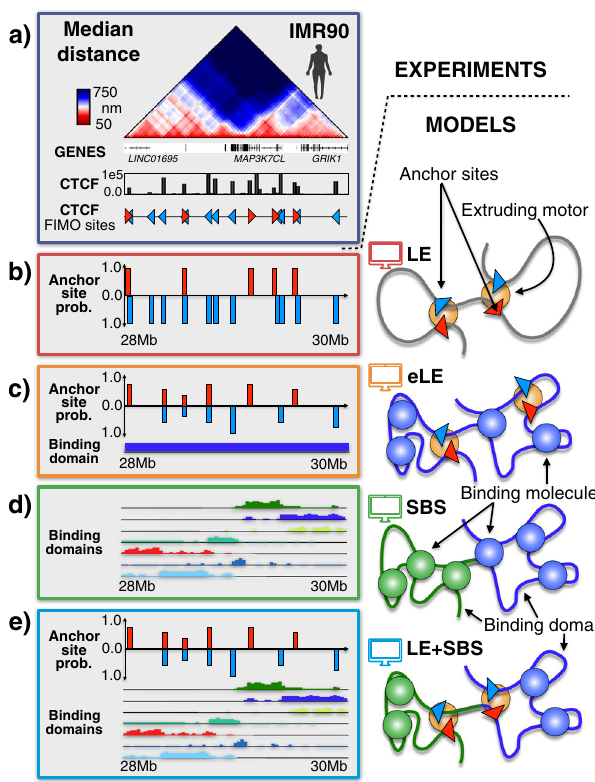
Fig. 1 Scheme of the investigated polymer models. We used Molecular Dynamics simulations to investigate polymer models where folding is based on two different physical processes: (i) DNA loop-extrusion and (ii) polymer phase-separation, recapitulated respectively by the LE 19,20 and by the SBS models 43,45 . a Microscopy median distance 6 and ENCODE 67 CTCF data are shown for the studied 2 Mb wide locus in human IMR90 cells. b We considered a simple Loop-Extrusion (LE) model 20 where active motors extrude polymer loops until encountering another motor or CTCF anchor points with opposite orientation, which are fi xed and equal in all single-molecule simulations (anchor probability = 1). c We also considered an extended version of the LE (eLE) whose anchor site locations are optimized, independently of CTCF, to best reproduce Hi-C and average microscopy data. To represent the epigenetic heterogeneity of single cells, those anchor sites have a fi nite probability to be present in a model single molecule 29 . d In the Strings and Binders (SBS) model 35 , a chromatin fi lament is represented as a self-avoiding chain of beads including different types of binding sites (colors) for diffusing cognate binders that can bridge those sites. The model undergoes a phase-separation of the chain in distinct globules 35 . The binding site locations are determined by the PRISMR method and correlate with different combinations of chromatin architecture factors including, but not limited to, CTCF and cohesin 28,35 . e We also considered a polymer model (LE + SBS) where in a single molecule both the eLE and SBS mechanisms act